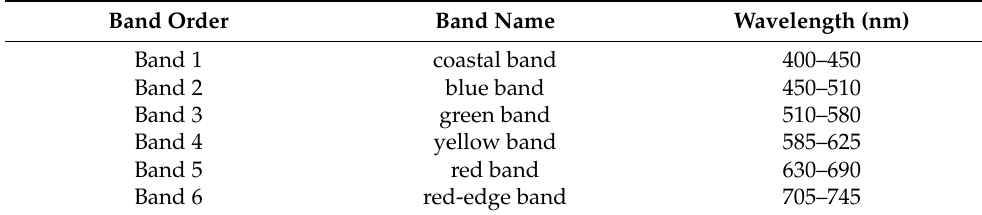
Table 1. The WorldView-3 image bands.